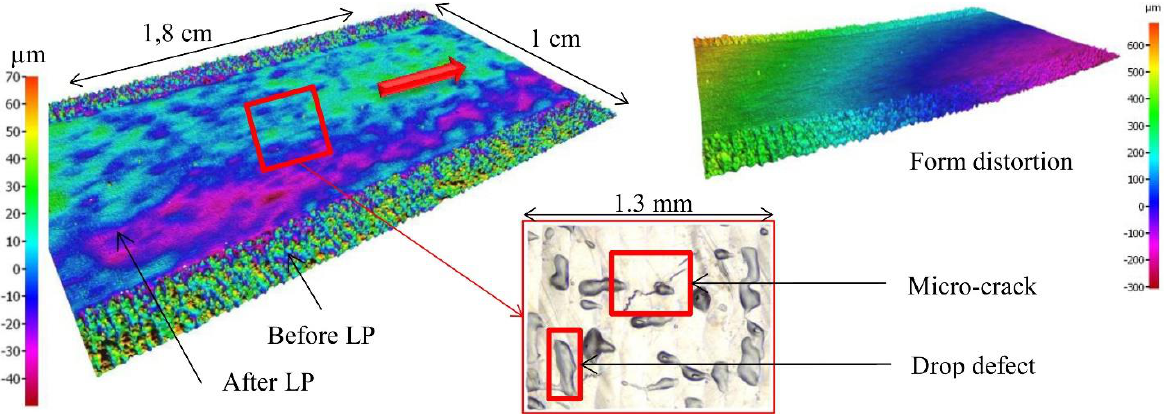
Figure 18. Surface morphology before and after laser polishing (LP) [88]; with permission from Jour- nal of laser applications.